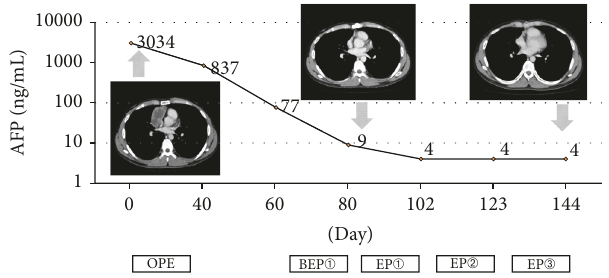
Figure 1: Case 1: a 22-year-old man received initial chemotherapy treatment. AFP: alpha-fetoprotein; BEP: bleomycin, etoposide, and cisplatin; EP: etoposide and cisplatin; OPE: operation.